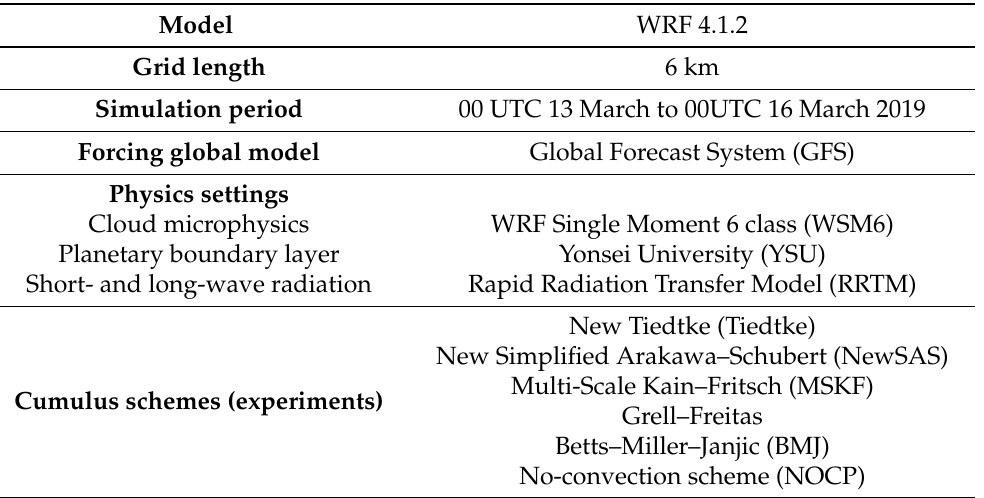
Table 1. Summary of experimental